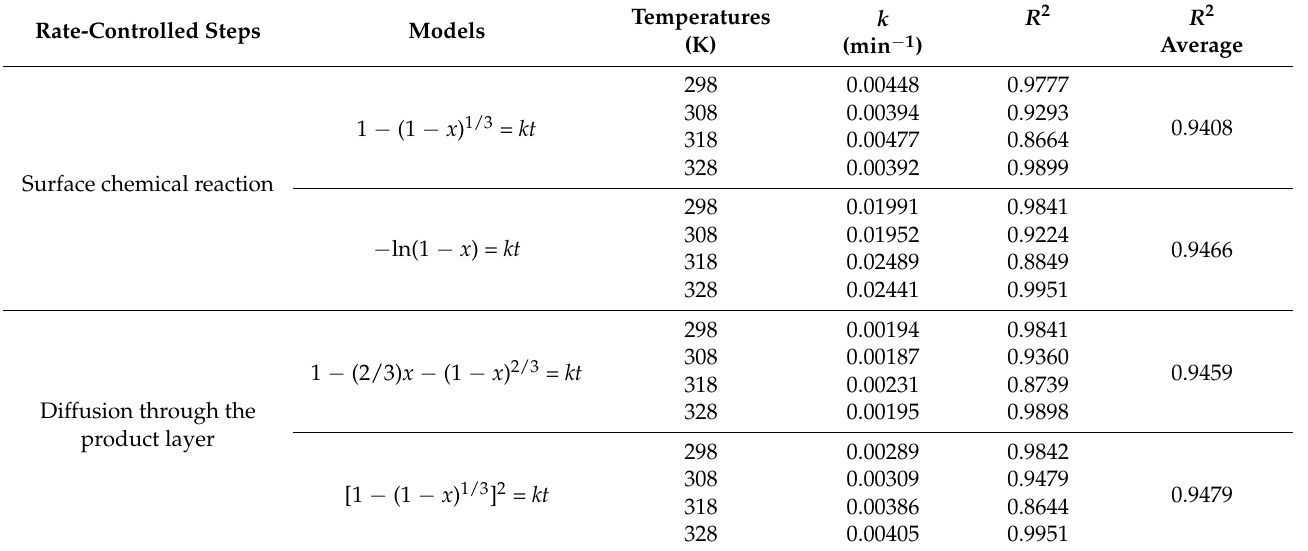
Table 1. The rate constants, k and the coefficients of variation, R 2 for each kinetics